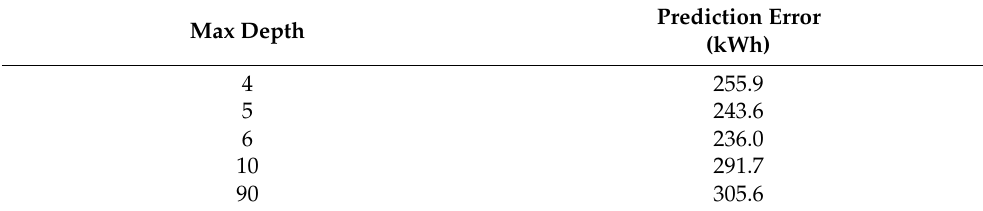
Table 3. Parameter tuning of PGPM based on Decision Tree. Table 2. Parameter tuning of PGPM based on SVR.